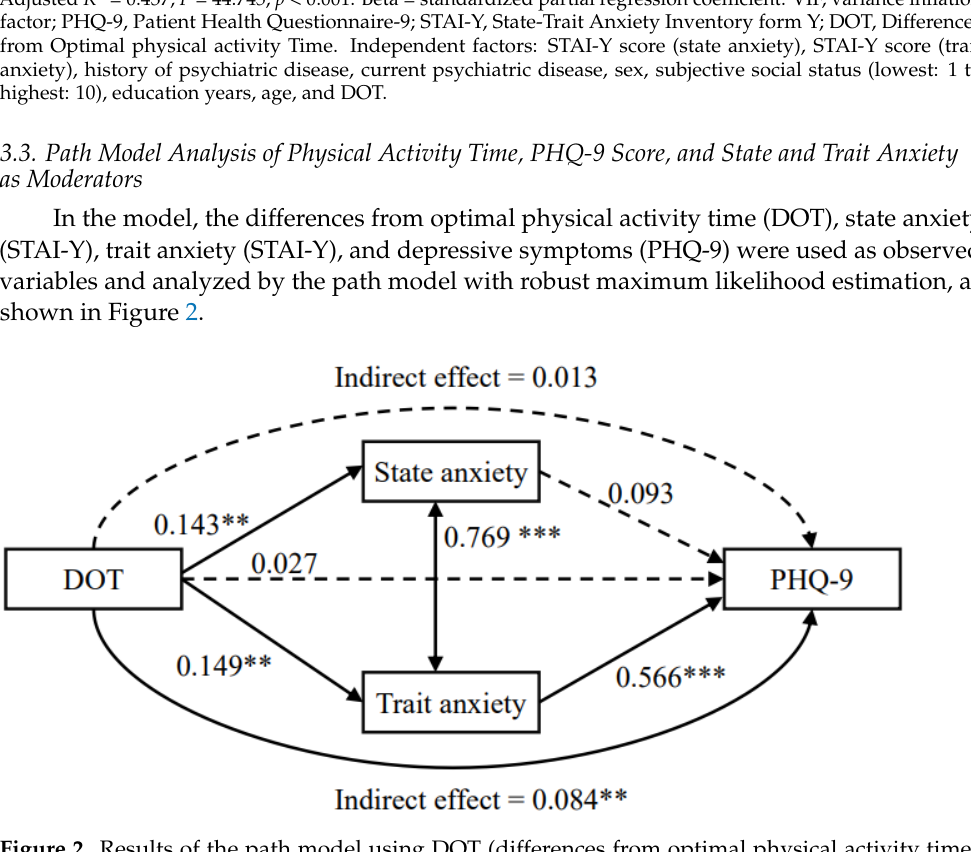
Figure 2. Results of the path model using DOT (differences from optimal physical activity time), STAI-Y (state and trait anxiety), and PHQ-9 (depressive symptom severity). Direct and indirect effects between the variables are shown. Values indicate standardized coefficients. ** p < 0.01, *** p <